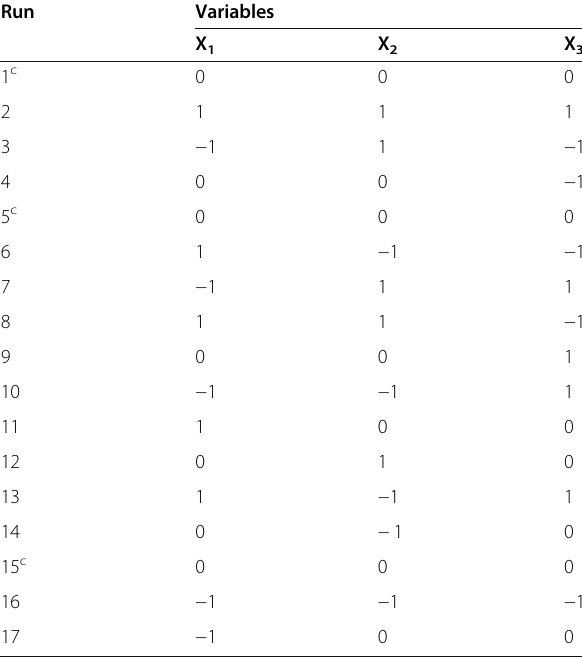
Table 2 The central composite design matrix employed for the three independent variables Run Variables X